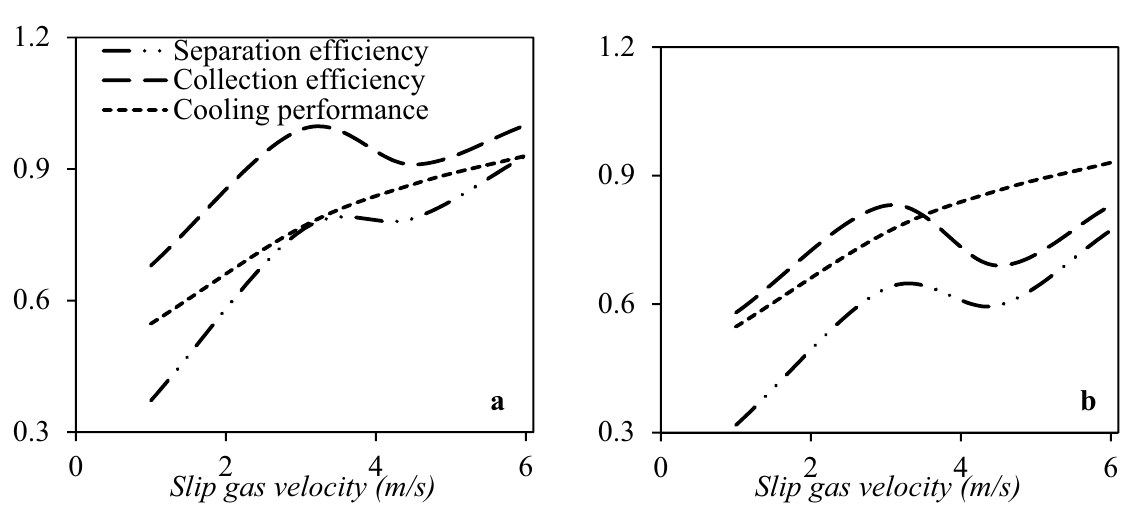
Figure 17. The influence of slip gas velocity on the collection efficiency, cooling performance and separation efficiency of 3S for ( a ) water droplets and ( b ) HC droplets—(PRR =